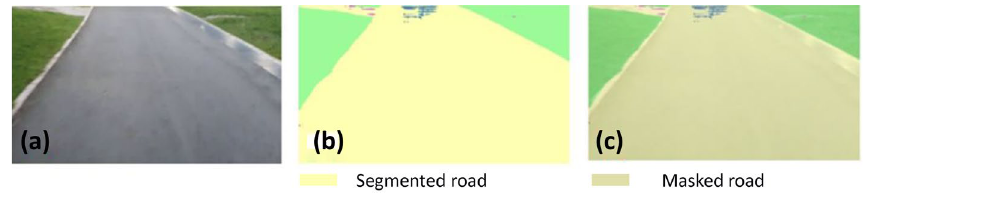
Figure 23. Online results: road.